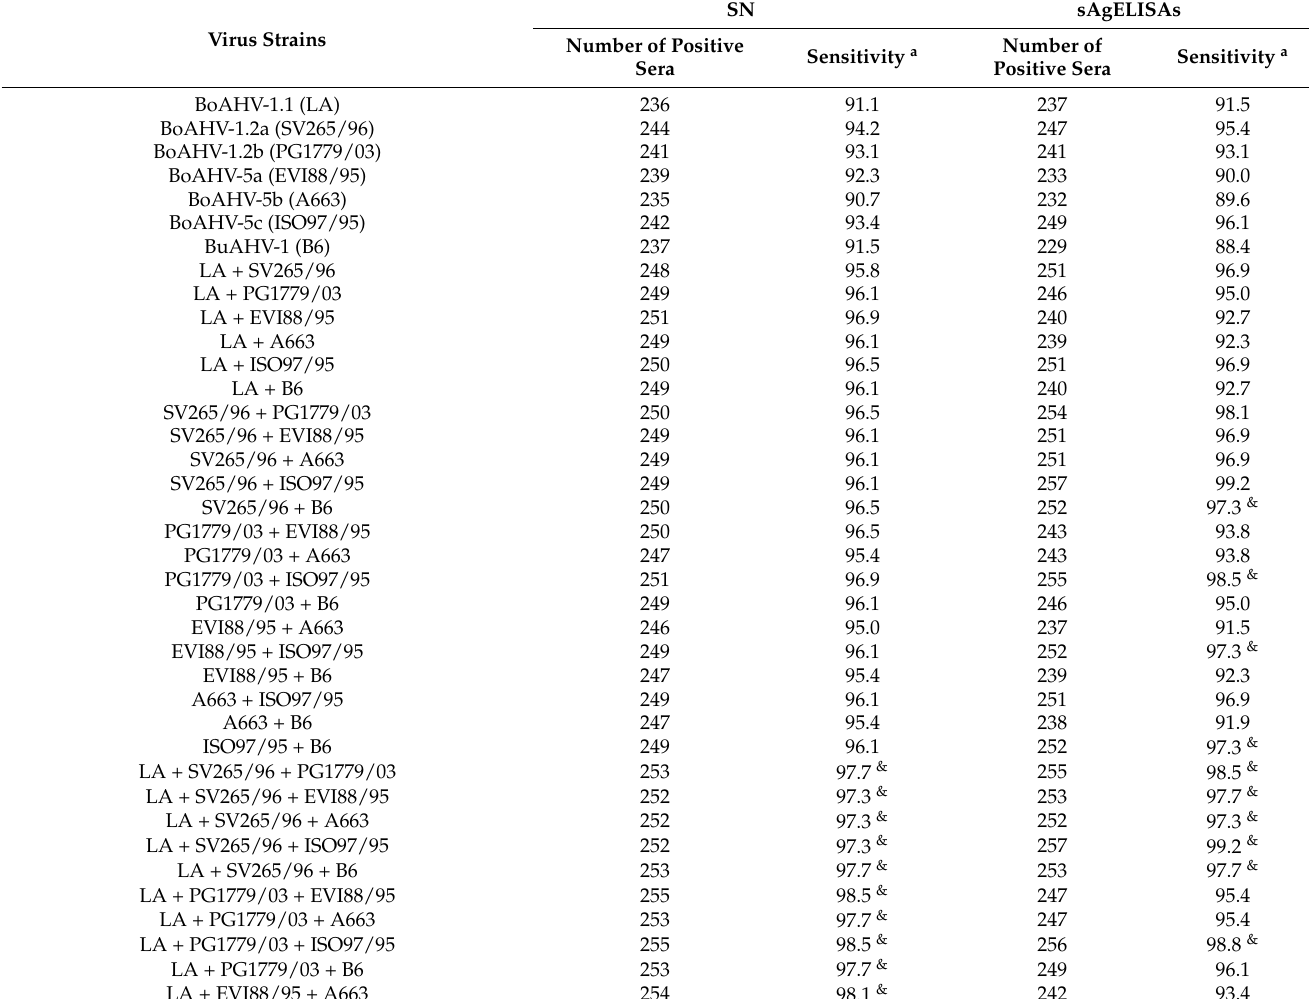
Table 1. Serum neutralization tests (SN) with bovine and bubaline alphaherpesviruses and the single antigen ELISAs (sAgELISA) (n = 259).